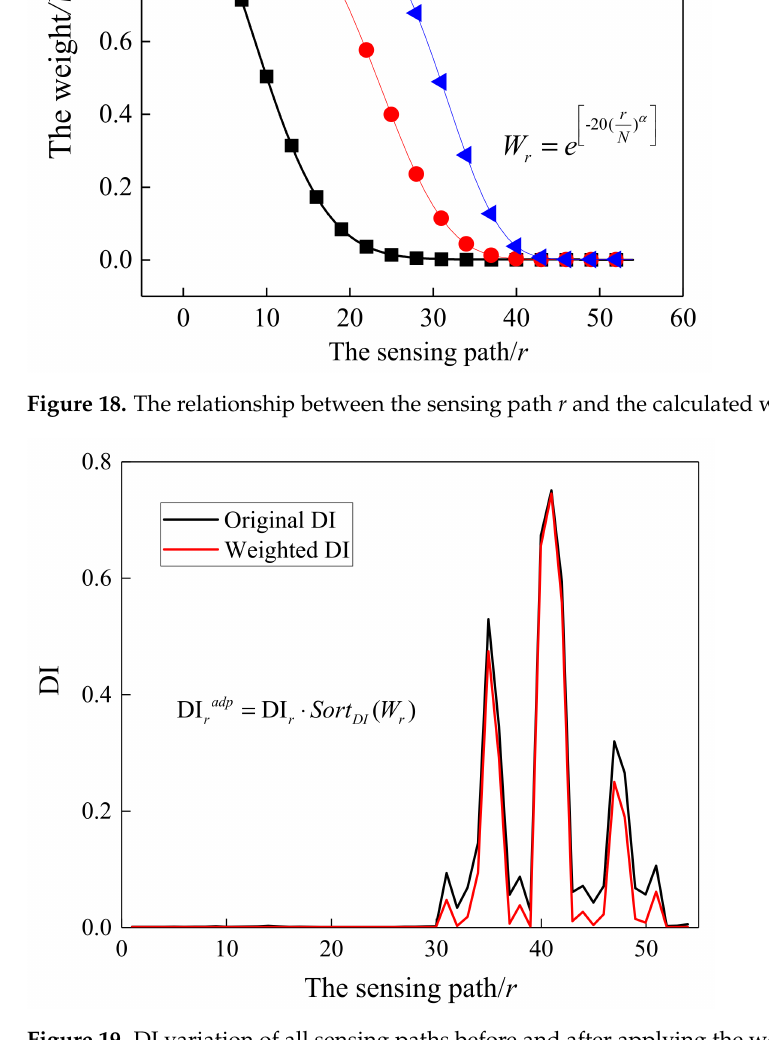
Figure 19. DI variation of all sensing paths before and after applying the weighted